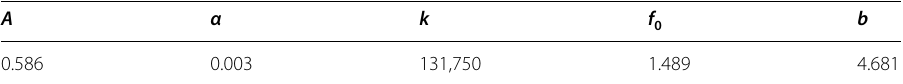
Table 2 Parameters of the updated coherency